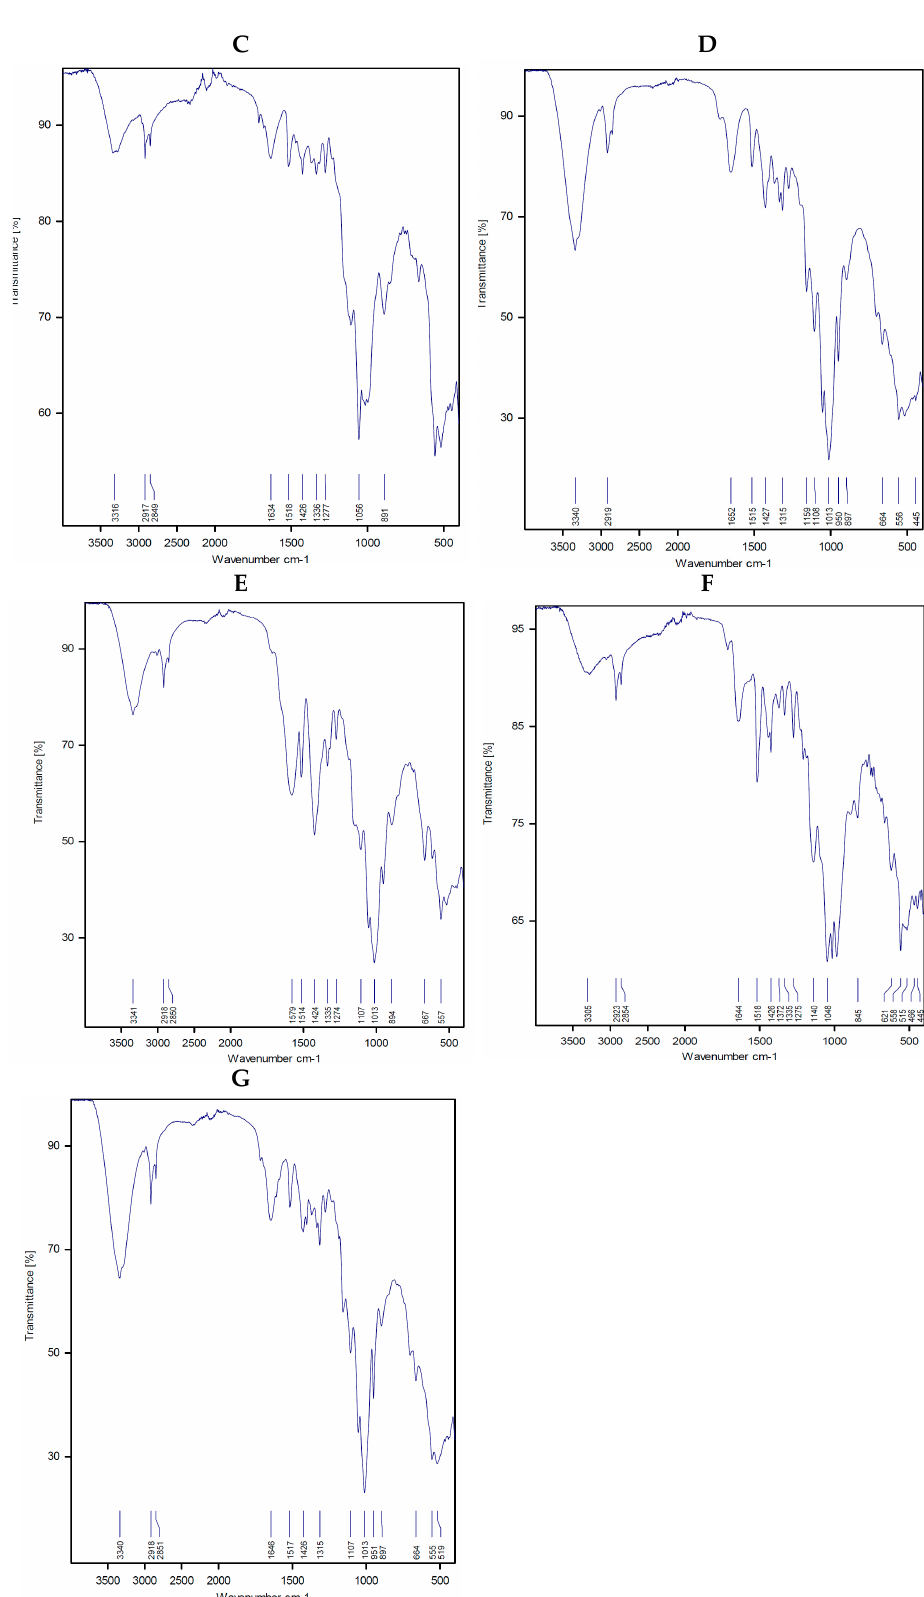
Figure 2. Infrared spectra of the ( A ) STG, ( B ) Mg(II), ( C ) Ca(II), ( D ) Cr(III), ( E ) Zn(II), ( F ) Cu(II), and ( G ) Se(IV)